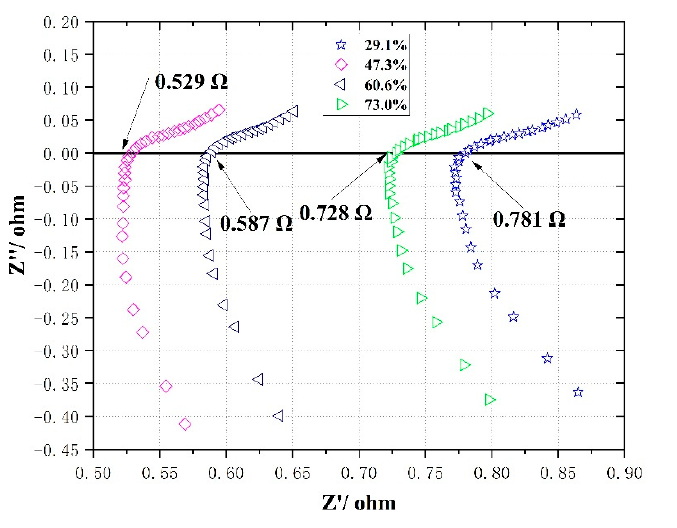
Figure 13. Nyquist plots of single-serpentine flow fields with different open ratios at high frequen- cies.